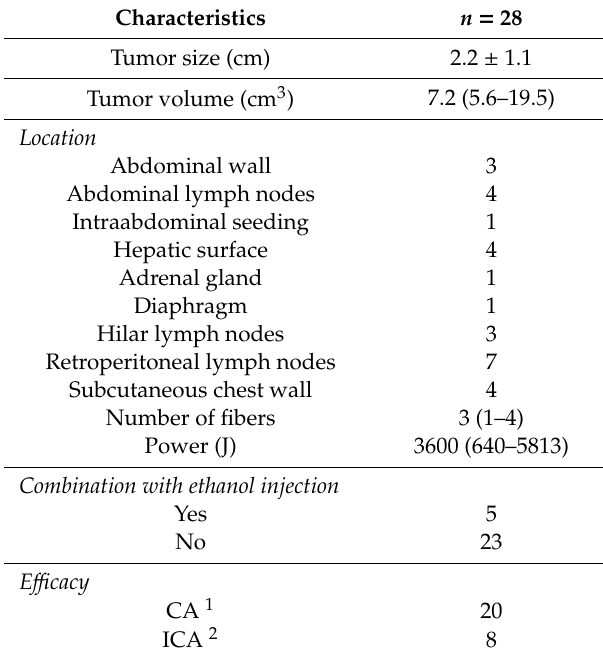
Table 2. Laser ablation strategies and